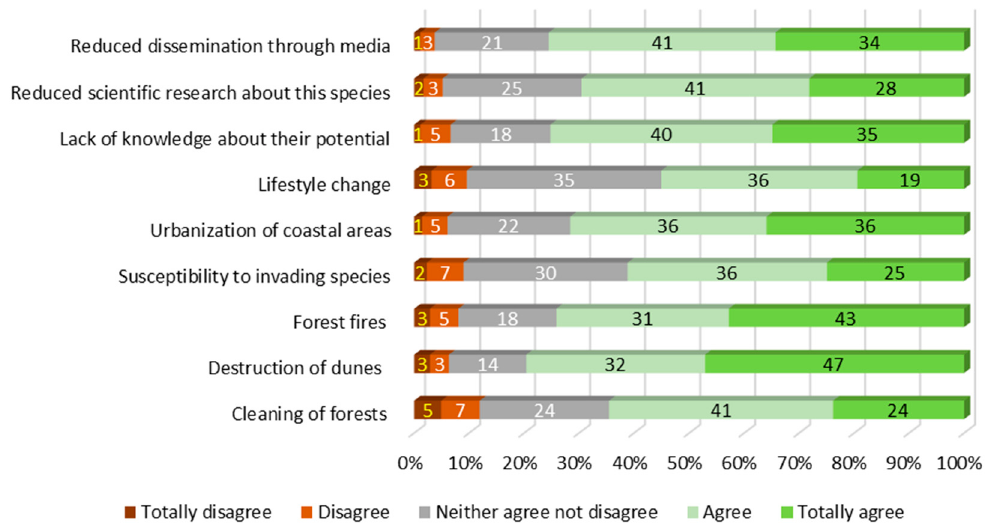
Figure 7. Possible factors contributing for the threatening of the crowberry species.